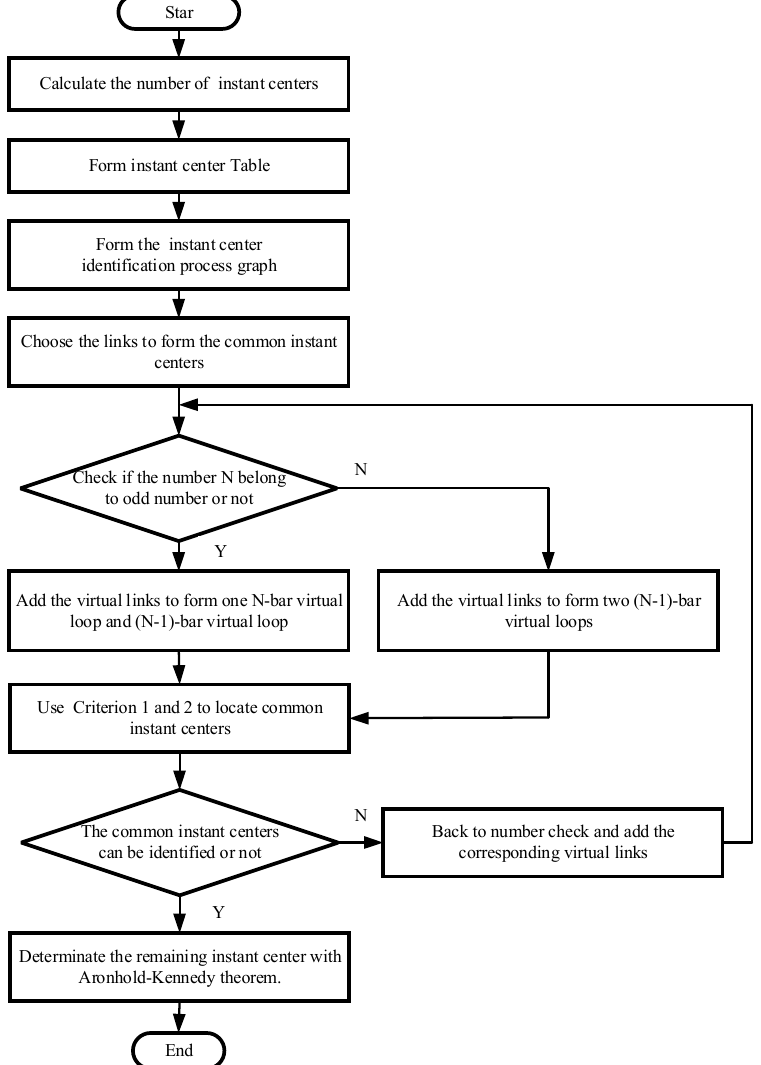
Figure 6. The flow chart of instant center identification for single-loop multi-DOF N-bar (N ≥ 5) planar linkage.